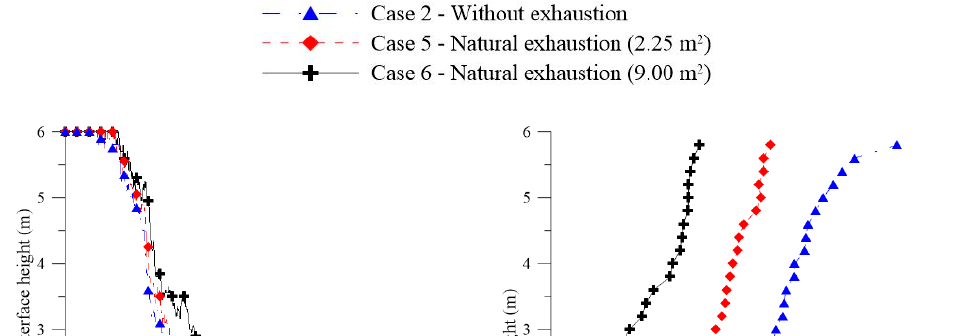
Figure 8. Temperature distribution in an xz plane that crosses two exhaust vents (y = 3.75 m) for different time periods (case 6). 3.2.3. Natural Exhaust with Different Heat Release Rates For compartments with natural exhaust area of 9.00 m 2 , Figure 9 shows the transient behavior of the smoke layer interface height, average exhaust volumetric flow rate and HRR, and the average temperature profile in different height at t = 600 s, for two heat release rates HRR = 225 and 900 W.